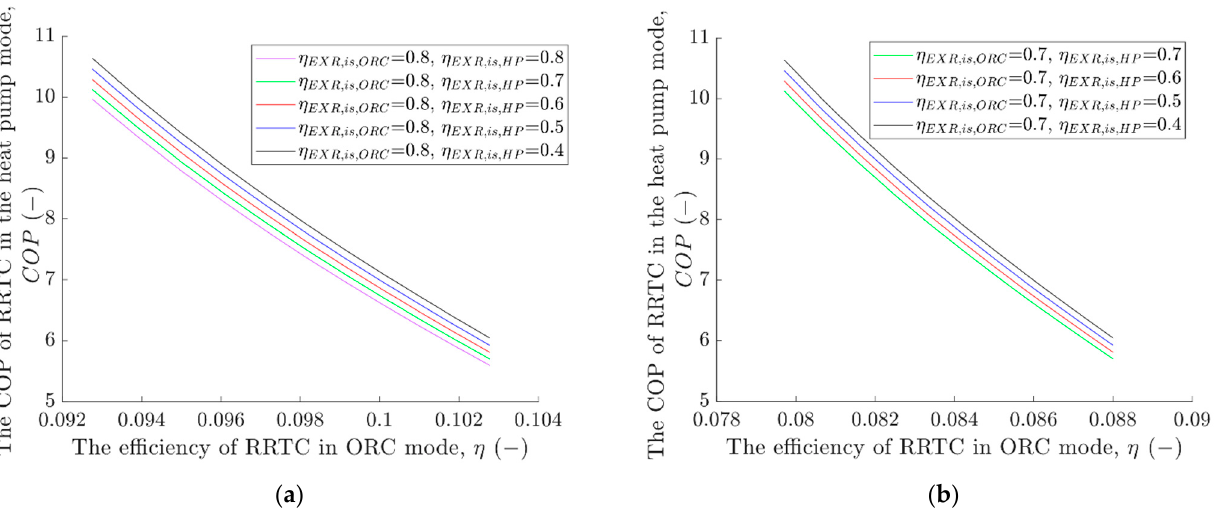
Figure 4. The obtained results for the RRTC in COP – η diagrams with the basis efficiency of the expander: ( a ) 0.8 and ( b ) 0.7.